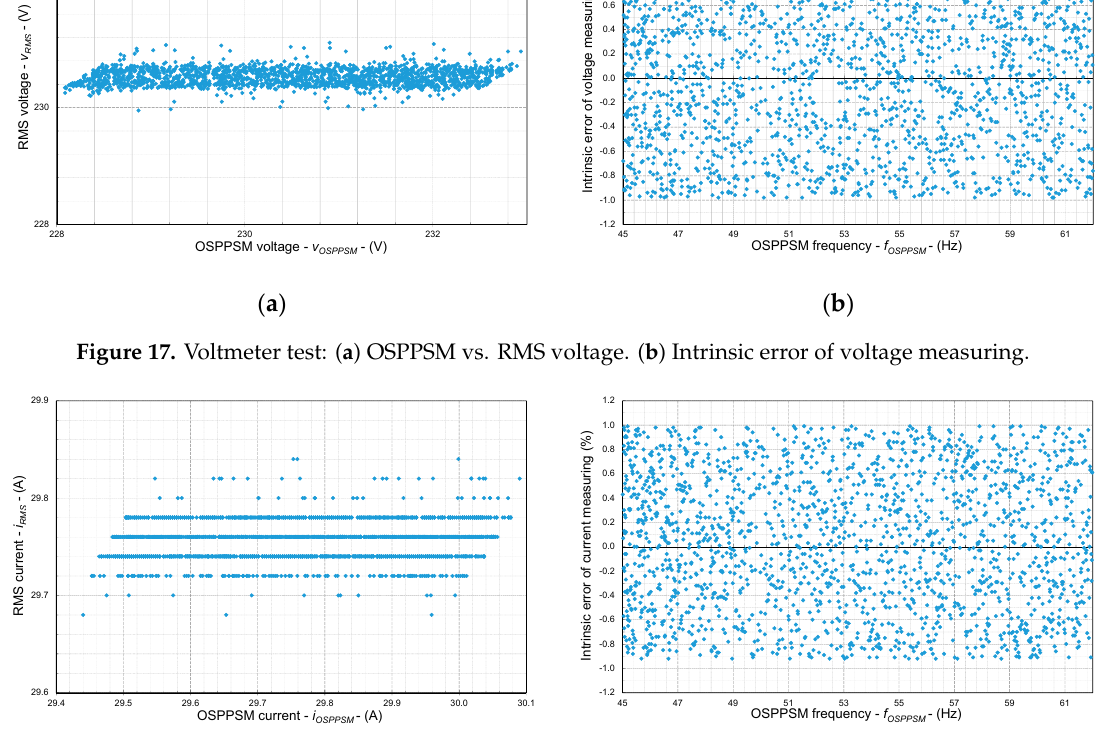
Figure 19. PF meter test: Intrinsic error of PF measuring ( PF : 0.5 lagging, 1, 0.5 leading).